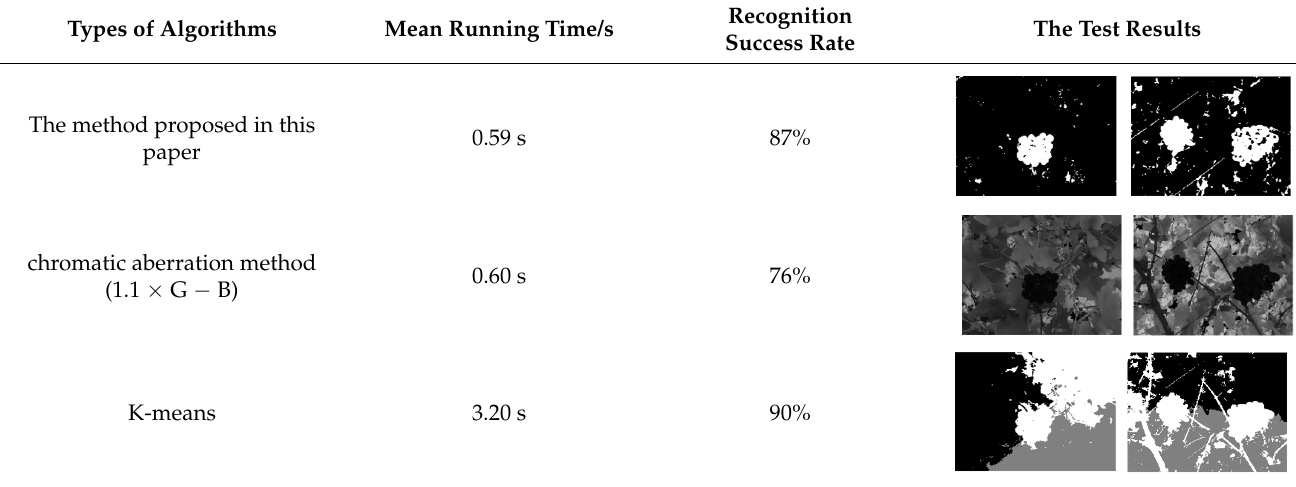
Figure 5. Image of partial test result. ( a ) Test 1. ( b ) Test 2. ( c ) Test 3. ( d ) Test 4. Table 1. Comparison of multiple methods.